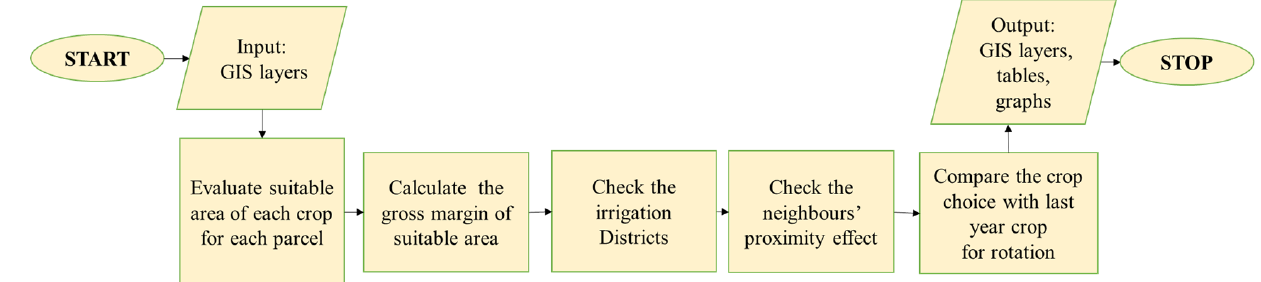
Figure 3. The process used to determine farming system selection in any given year.